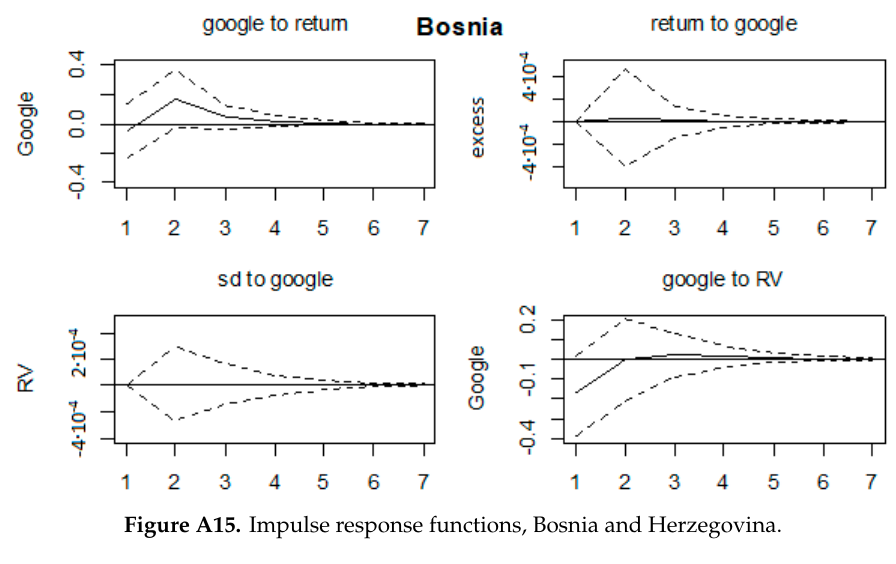
Figure A14. Impulse response functions, Ukraine.